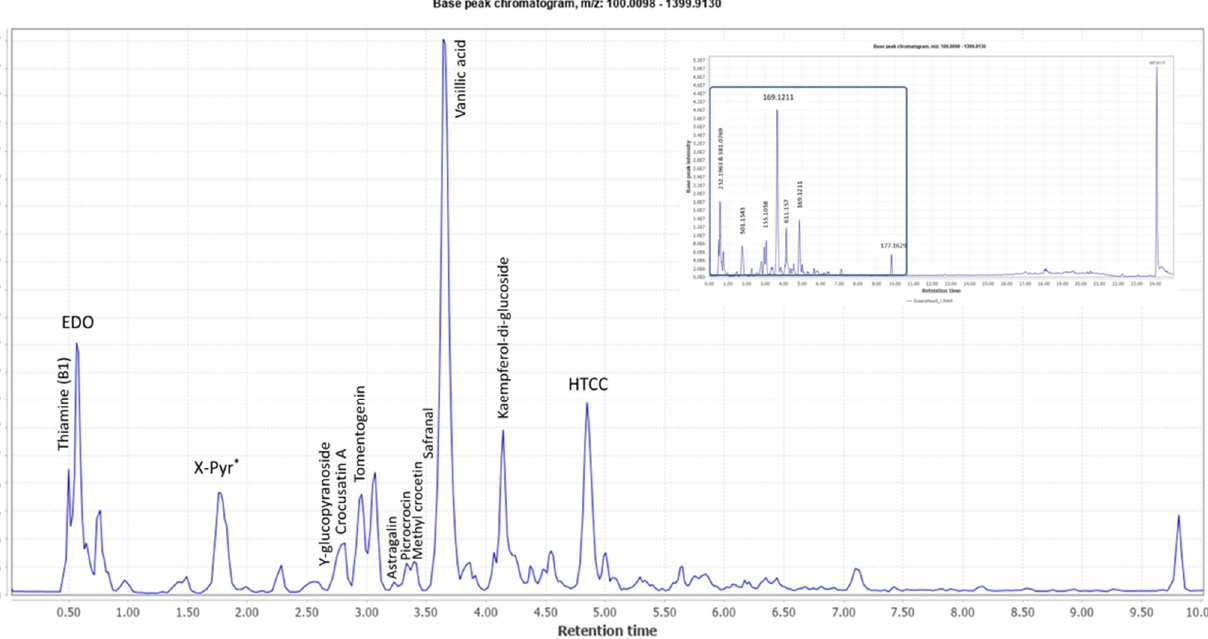
Figure 1. Characteristic ultra-performance liquid chromatography coupled to high resolution mass spectrometry (UPLC-HR MS) base peak chromatogram of the stigma extract from the C. sativus L. sample from India. This represents the early eluting part of the chromatogram shown in the inset. Several peaks have been annotated in the early eluting part of the chromatogram with the names of the putative metabolites shown in Table 1. * X-Pyr: 3,4,5-Trimethoxyphenol-1-O-[ β -D- apiofuranosyl-(1 → 6)]]- β -D-glucopyranoside.